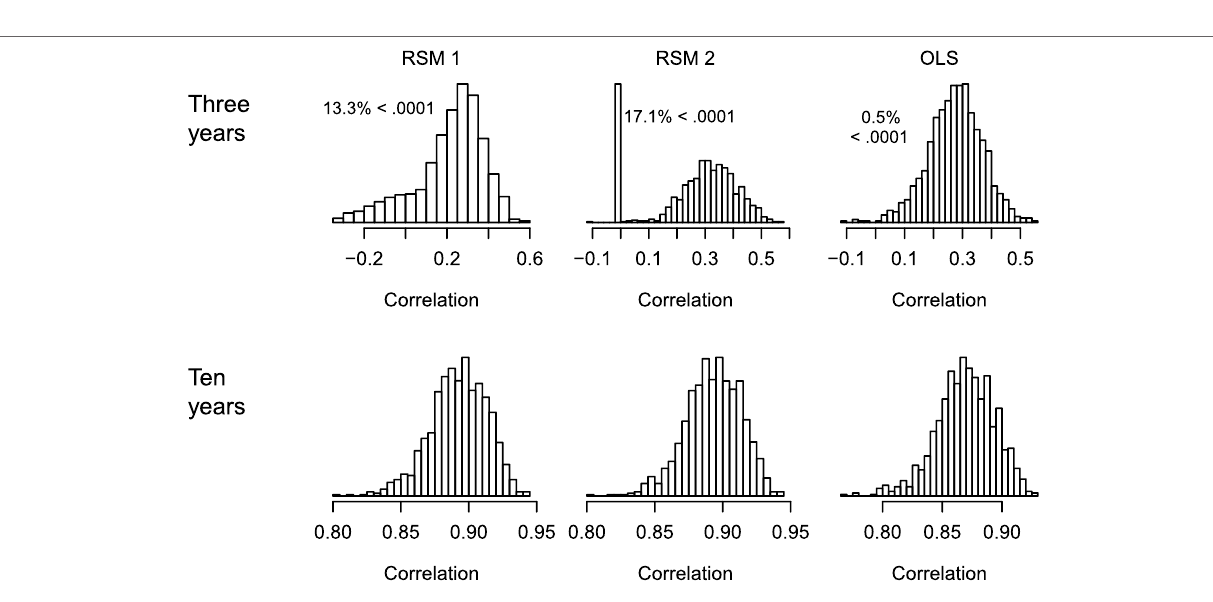
FIGURe 5 | Histograms of the correlations between the estimated and true underlying slopes for the different estimation methods when there are 3 and 10 years of data. Simulation 1 (normally distributed linear relationships). RSM 1 and RSM 2 refer to estimating the correlation between the random variables (1) and fixing it at zero (2).